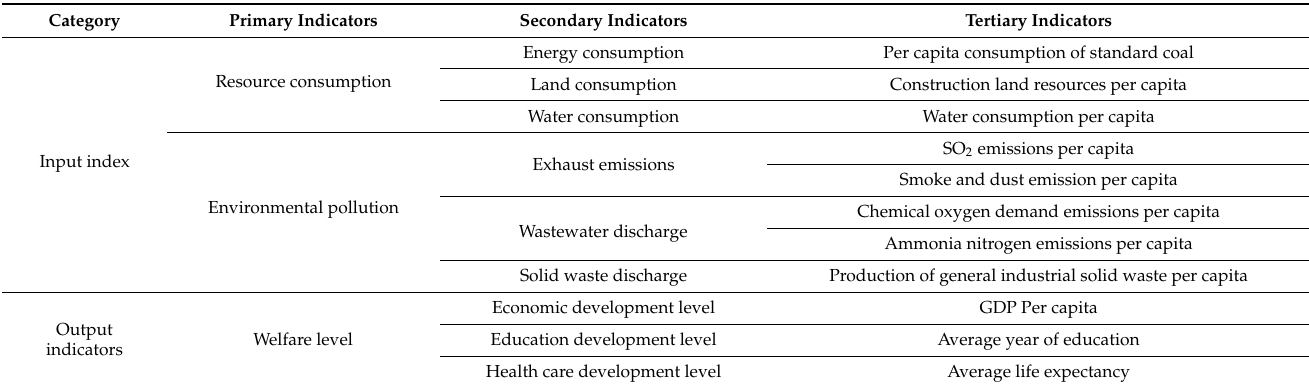
Table 1. Index system of ecological well-being performance in